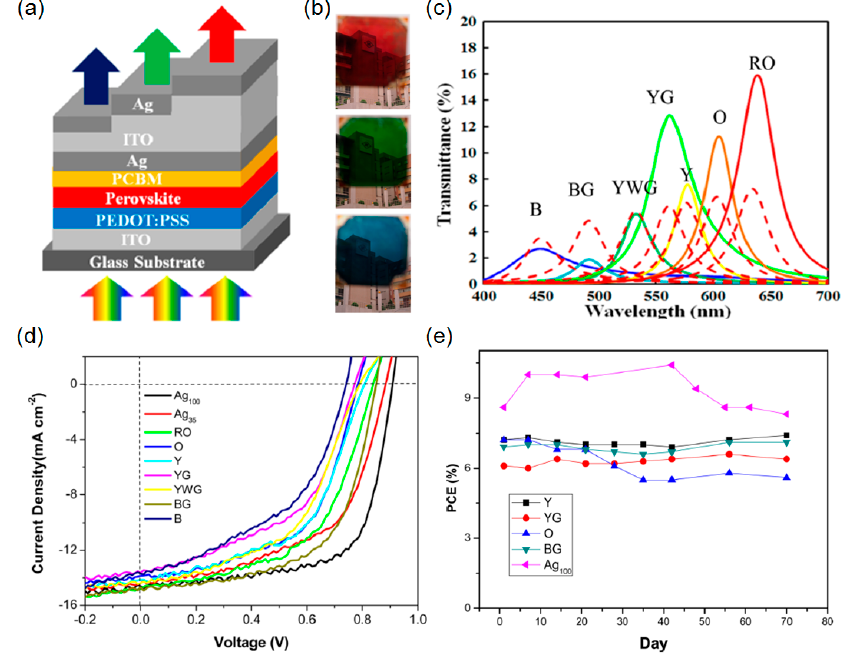
Figure 9. ( a ) Schematic representation of microcavity-based semitransparent perovskite solar cells. ( b ) Images of fabricated colored solar cell devices. The background image can be clearly seen through our fabricated samples with various colors. ( c ) Simulated (dashed lines) and measured (solid lines) spectral transmittance curves of the perovskite solar cell devices. (B: blue; BG: blue-green; YWG: yellowish-green; YG: yellow-green; Y: yellow; O: orange; RO; reddish-orange) ( d ) J - V characteristics of various colored devices under illumination with AM 1.5G solar simulated light (100 mW cm -2 ). (Ag 100 :Ag = 100 nm; Ag 35 :Ag = 35 nm) ( e ) Long-term performance of the perovskite cells. Reproduced with permission [17]. Copyright 2016, American Chemical Society.